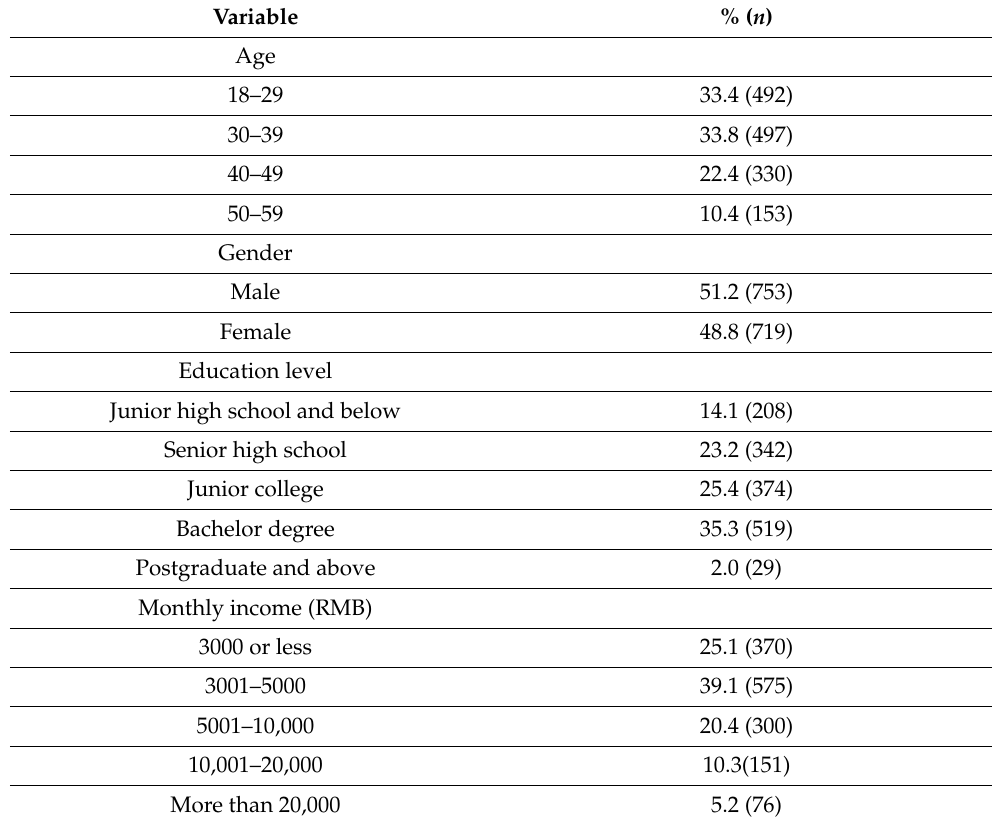
Table 2. Participants’ demographic characteristics ( n